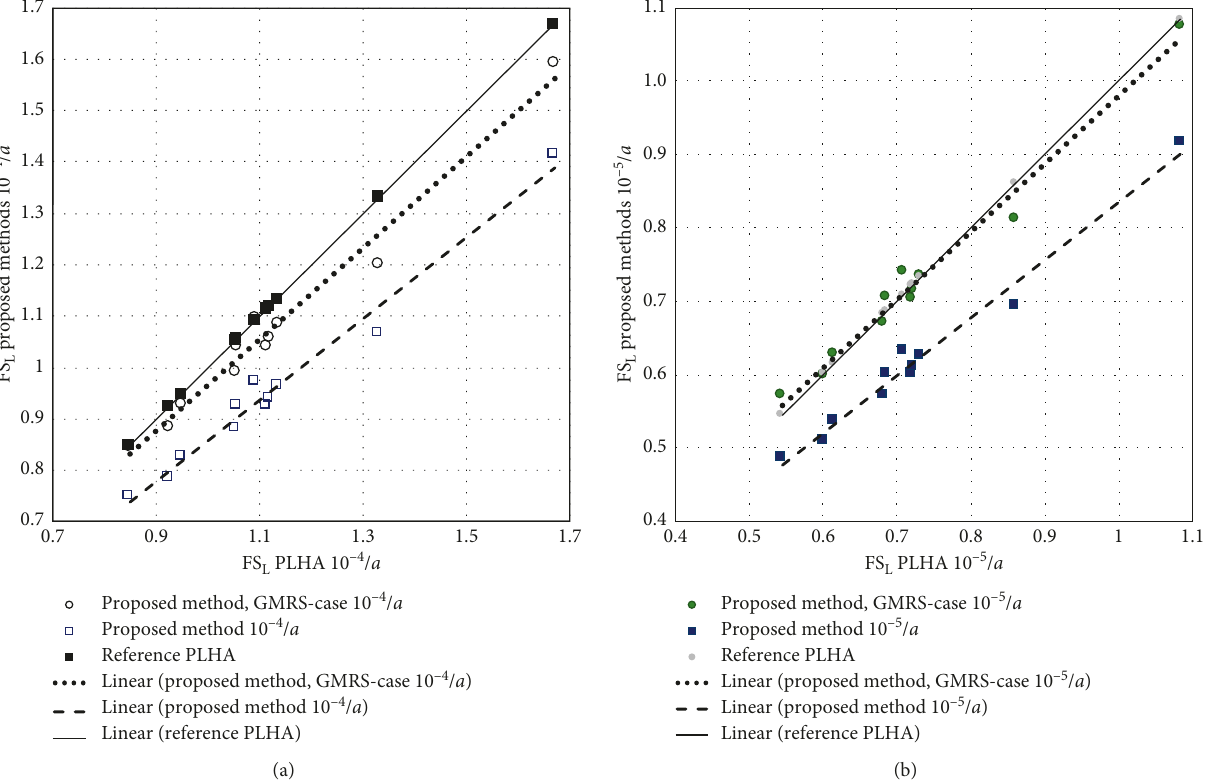
Figure 8: Comparison of FS L results via PLHA to the FS L values calculated by two options for the proposed method (hazard levels 10 and 10 − 5 / a